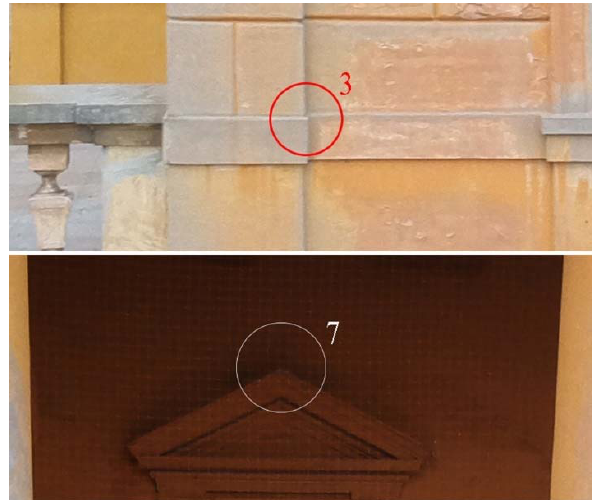
Table 2. Points and polygon created during SfM